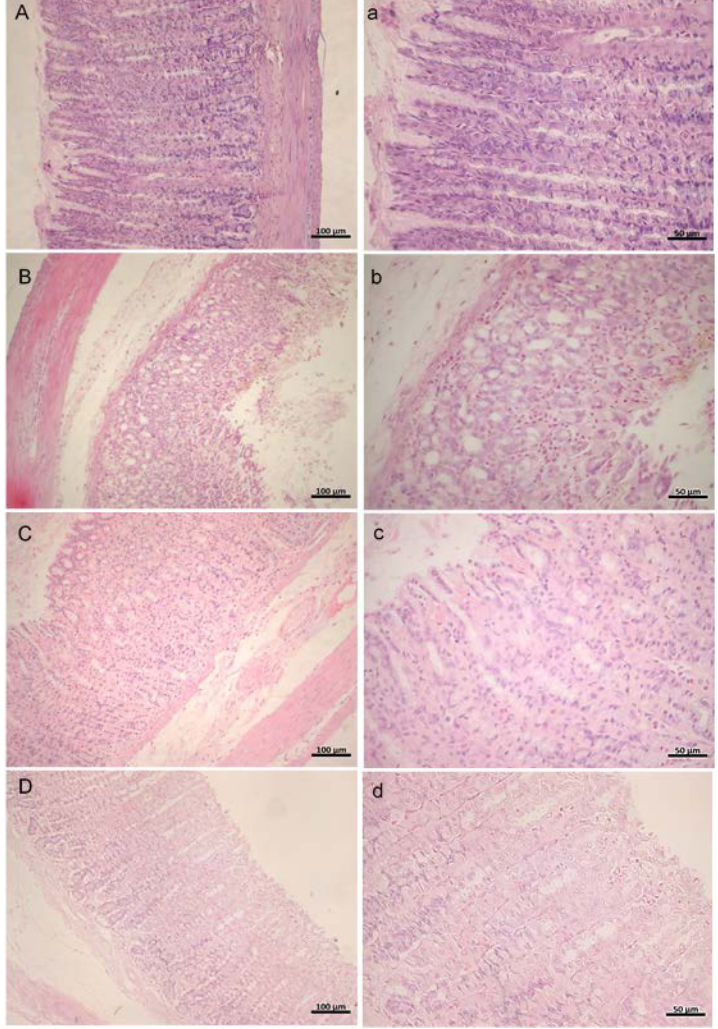
Figure 2. H&E staining of rat gastric mucosa in ethanol-induced gastric ulcers (magnification at 20 × and 40 × ). ( A , a ) Vehicle control; ( B , b ) ulcer control; ( C , c ) omeprazole (40 mg/kg); ( D , d ) ExPhy (400